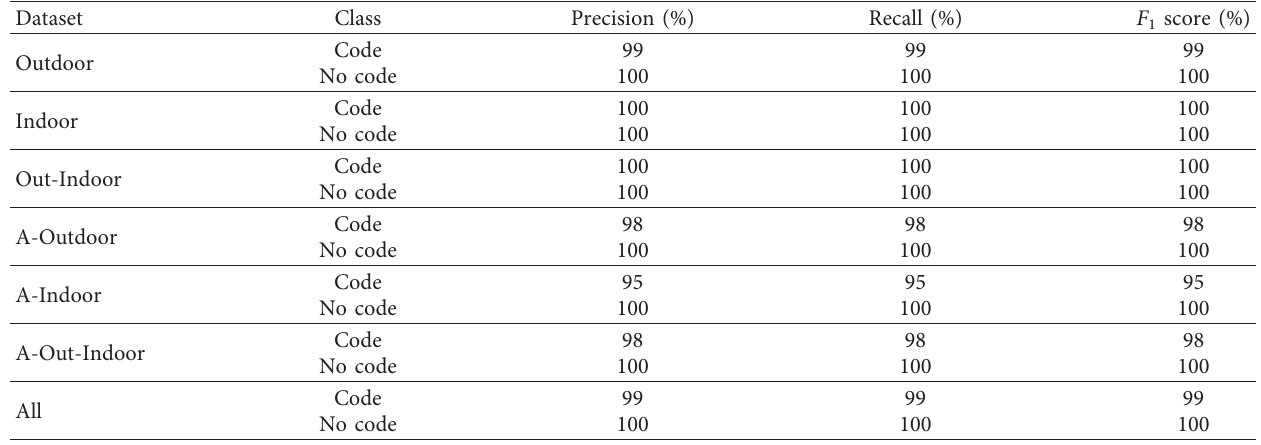
Table 6: Average performance evaluation results.